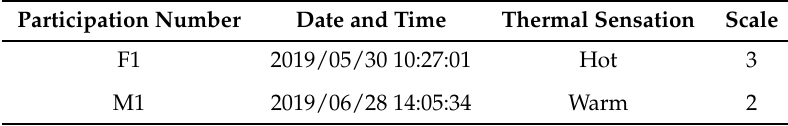
Table 5. Subjective comfort data record structure example.